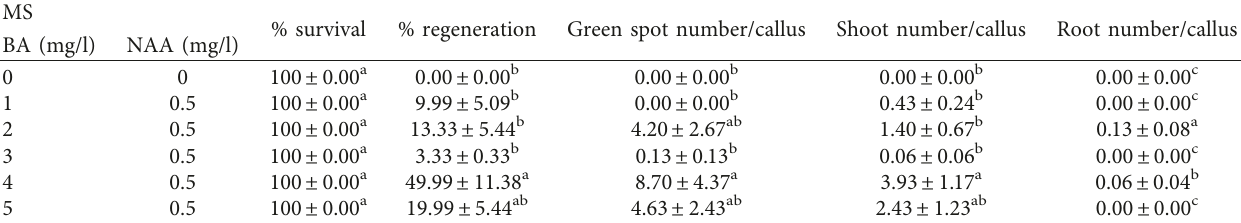
SE, n 30. Values followed by different superscripts in the same column are significantly different according to ANOVA and Duncan’s Multiple (cid:30) Range Test ( P ±